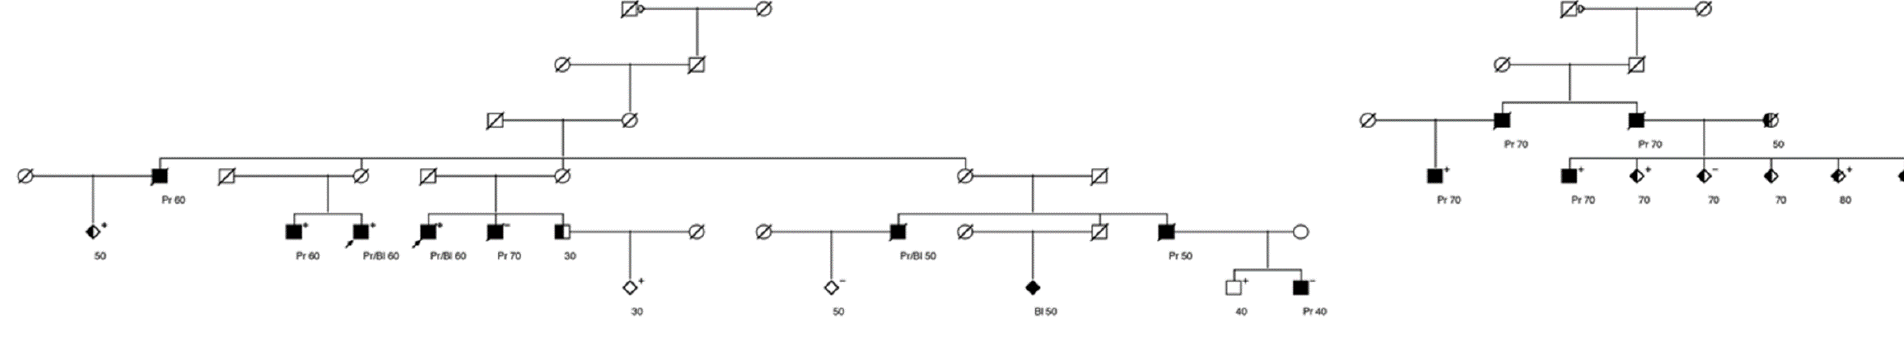
Figure 1. Pedigree segregating rare ERF variant. The male founder is shown with two marriages, indicated with an arrow on the marriage line. Sampled cancer cases and relatives are shown; assayed variant carriers are shown with “+”, the original sequenced bladder-cancer-affected cousin probands are indicated with an arrow. Prostate cancer cases are fully shaded, individuals with cancers of other sites are half-shaded; case details are censored to protect confidentiality.